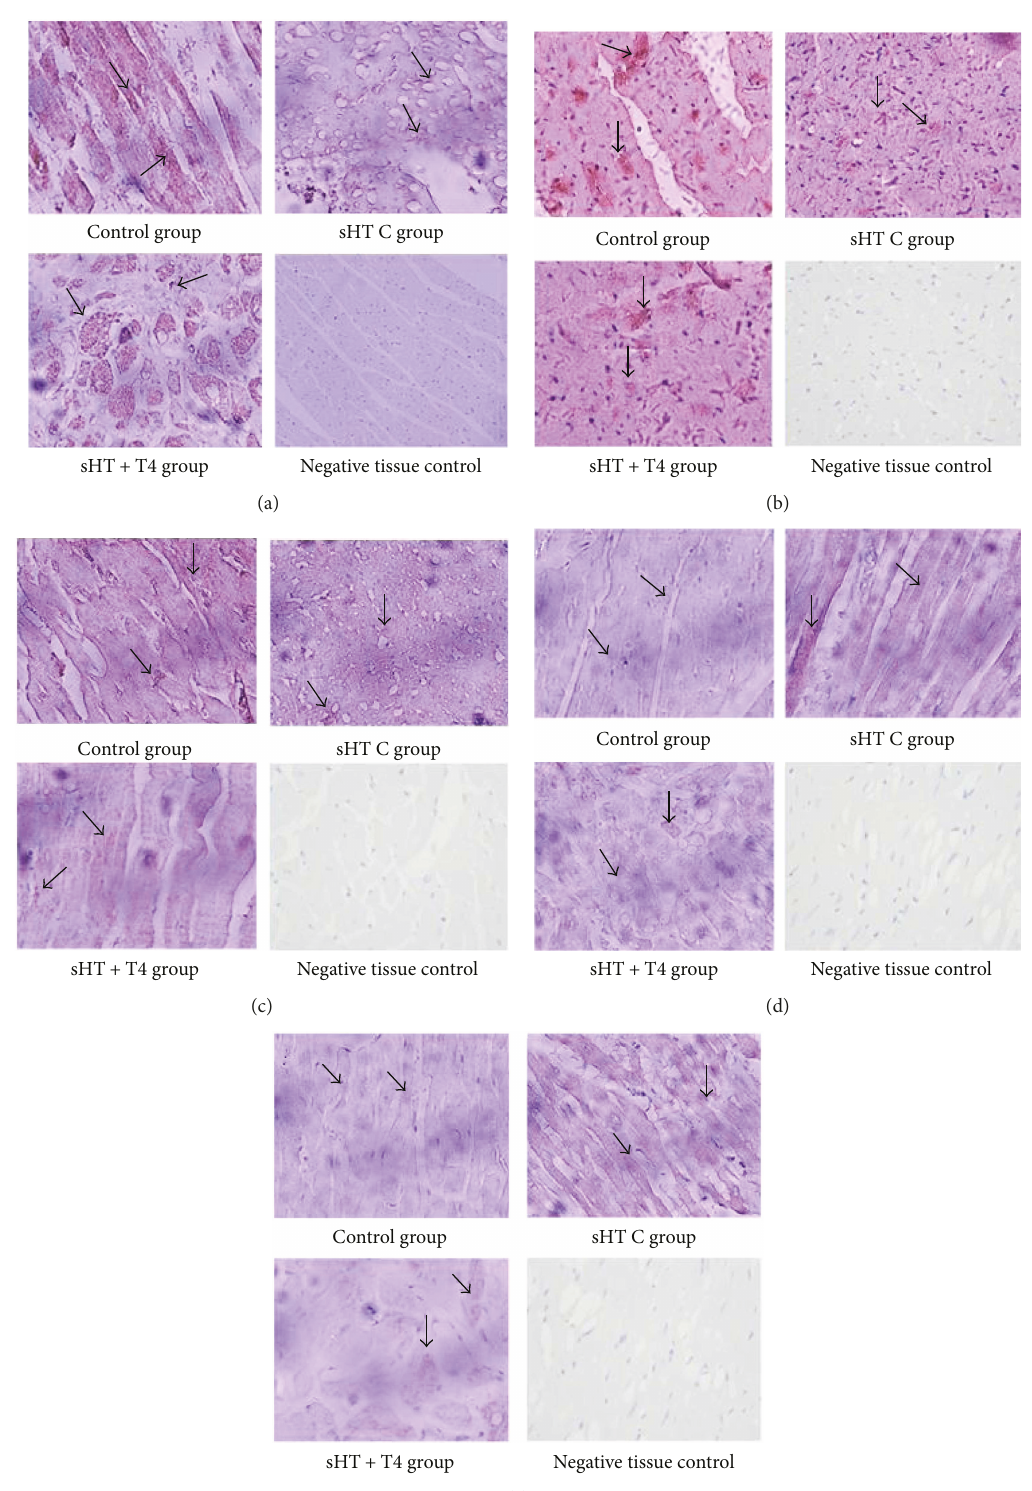
Figure 5: Representative histological sections of the cardiac muscle stained with immunohistochemical